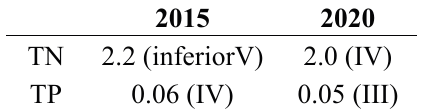
Table 2. Water quality Targets (annually average value (mg/L)) for TN and